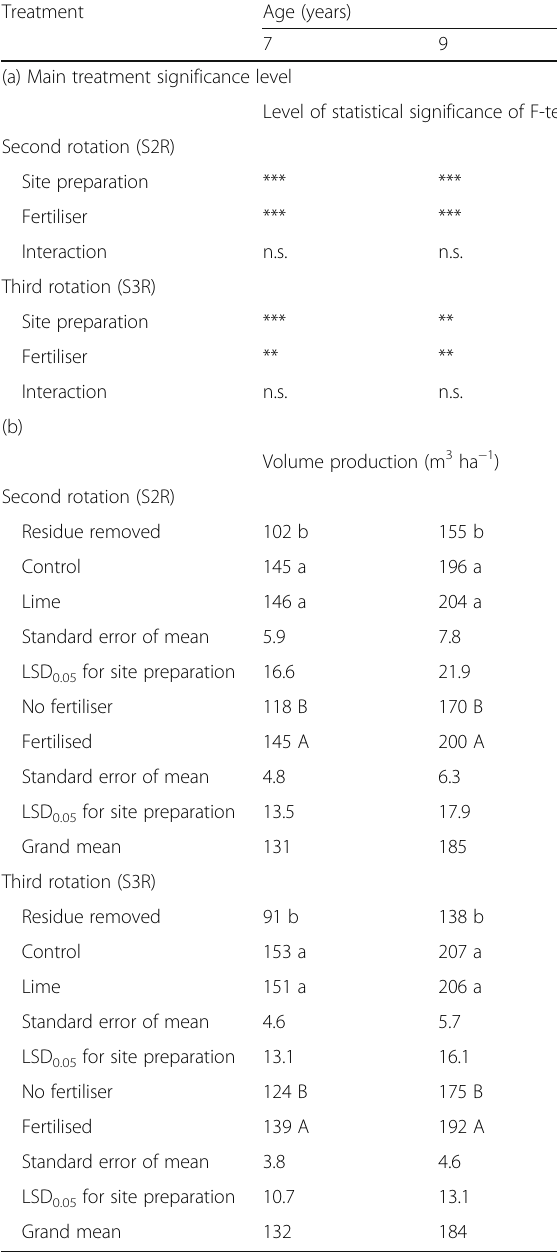
Different letters indicate significant differences between the means at the 5% level within each rotation. Lowercase letters for site preparation and uppercase for fertiliser n.s. not significantly different *=5% level, **=1% level, ***=0.1%